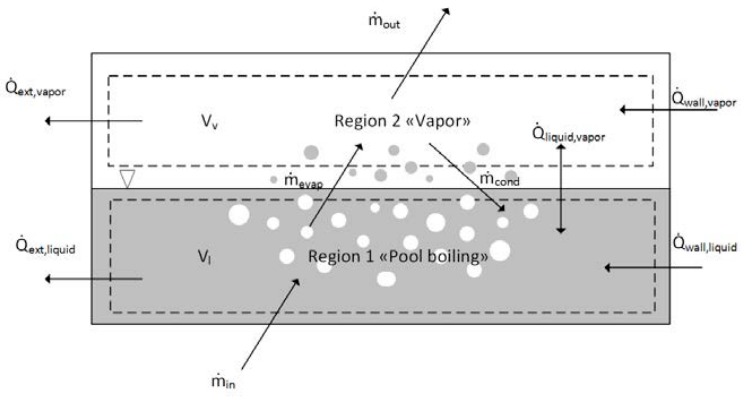
Figure 2. Two-volume cavity (TVC).